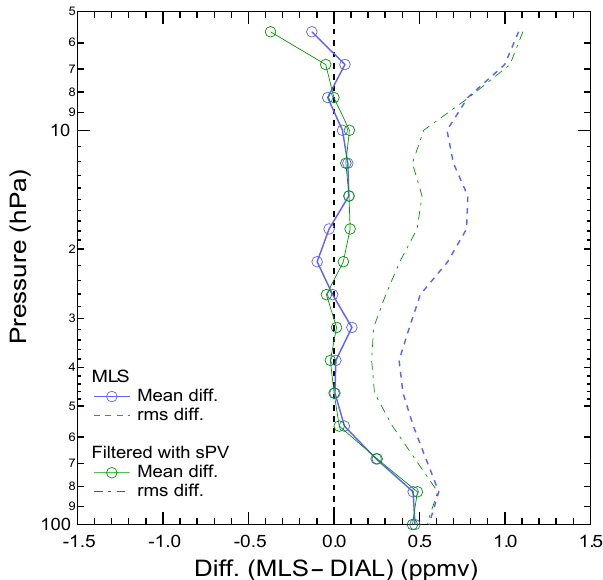
Figure 11. Vertical profiles of mean and rms differences with and without scaled PV criterion screening for the DIAL–MLS O 3 com-